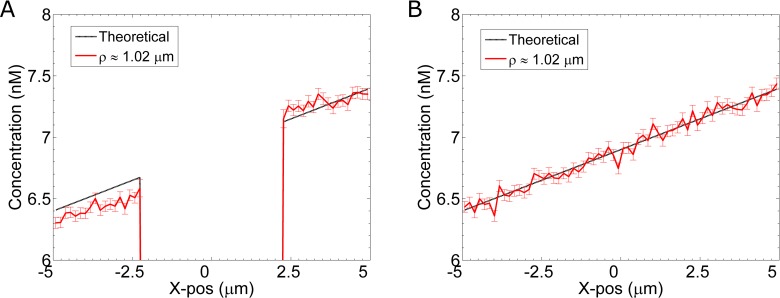
Steady-state Gradient Profiles when Molecules are only Injected from One Side.Pheromone molecules are added at the x = 5μm boundary and a partially absorbing boundary is placed at x = –5μm boundary (see Methods: “Gradient Method 2”). (A) The steady state concentration profiles in the presence of a cell. We do not simulate any reactions. (B) The steady state concentration profile in the absence of a cell. Note that the presence of the cell sharpens the gradient and reduces the overall concentration behind the cell.